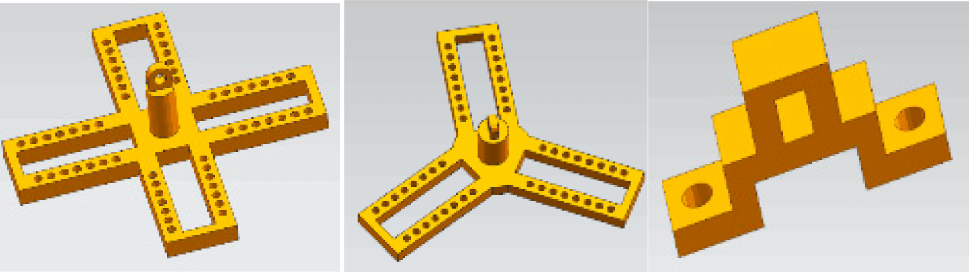
Figure 3. Structure diagram of pneumatic gripper